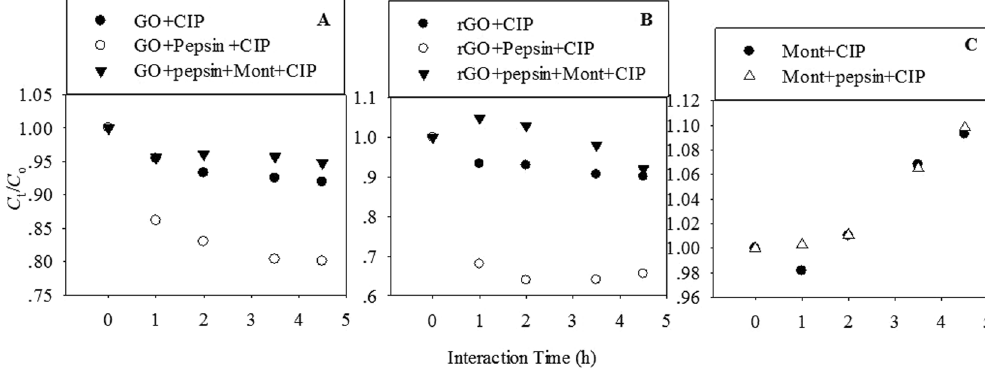
Figure 6. Interaction of CIP with GO, rGO and Mont under the varying interaction systems at the simulated intestinal fluids. C 0 was the concentration of CIP at 0 h, and C t was the concentration of CIP at 1, 2, 3.5, and 4.5